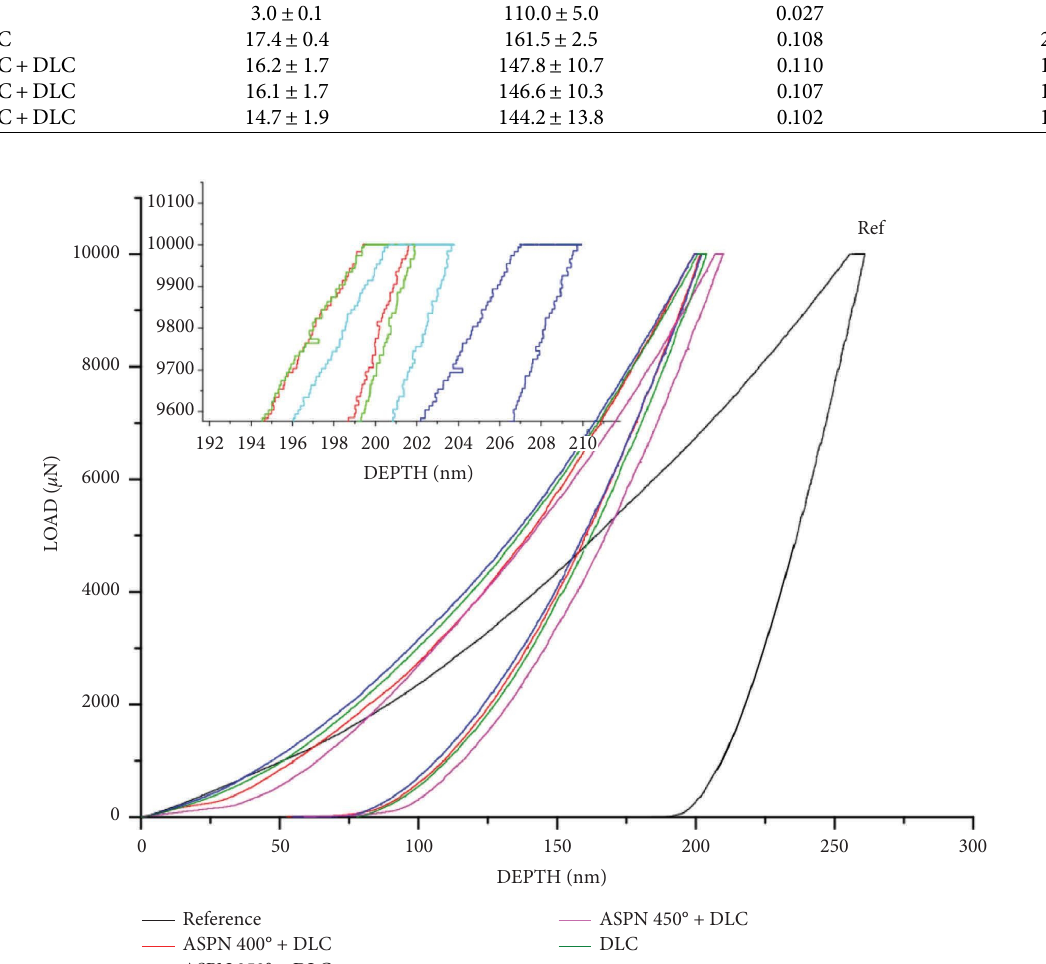
Figure 4: Nanoindentation curves of the WC: C coating (light blue plot), ASPN 350 ° C +DLC (light green plot), ASPN 400 ° C+DLC (red plot), ASPN 450 ° C+DLC (dark blue plot), and reference AISI316-L (dark green plot)